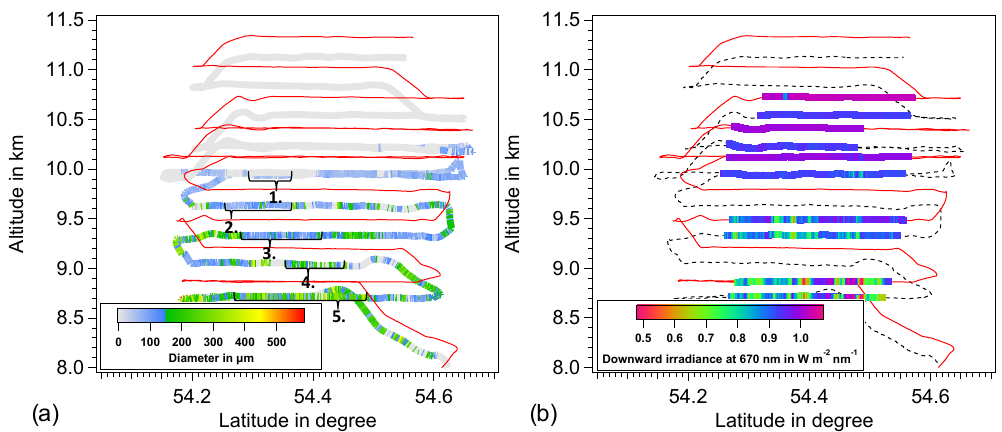
Figure 6. Both panels show the flight path of the Learjet (red line) and the flight path of AIRTOSS (dashed line) on 4 September 2013 with an overlay showing colour-coded measurements of particle mean diameter (a) and downward irradiance at 670nm (b) . The flight sections used to calculate the mean particle diameter for specific legs are indicated in (a) .